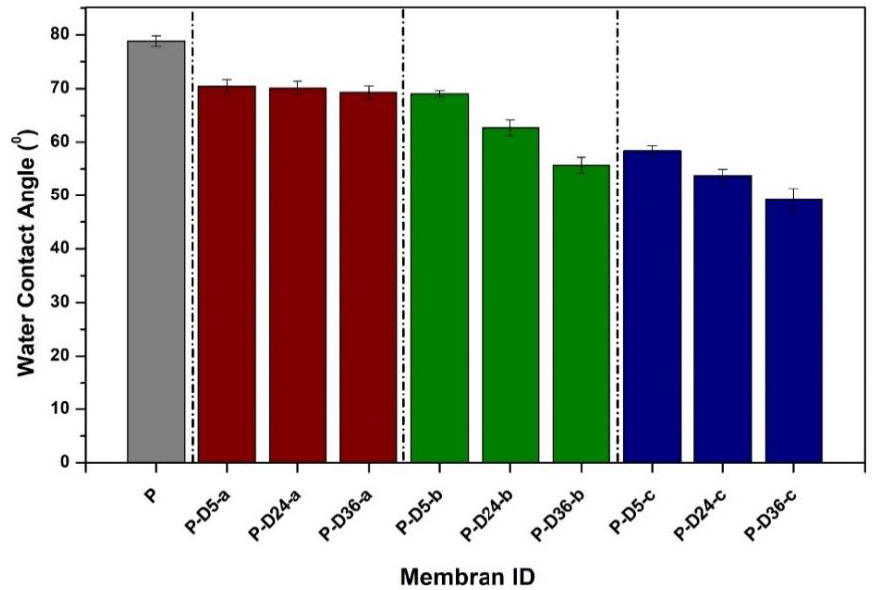
Figure 3. Water contact angle of the prepared membranes. The data are presented as average ± standard deviation from n = 10.